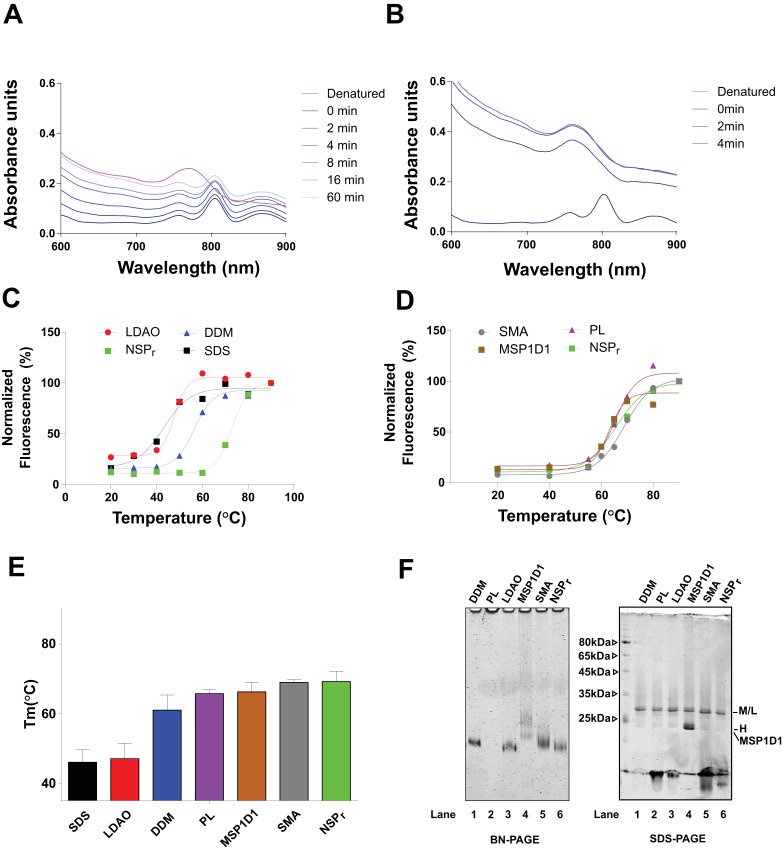
Effect of peptidisc on BRC stability.(A) Absorbance scans of the BRC complex (1 µM) in peptidisc after incubation at 65°C for up to 1 hr (blue traces). Incubation at 90°C leads to full release of the bacteriochlorophyll pigment (magenta trace). (B) Absorbance scans of the BRC (1 µM) after incubation at 65°C in 0.03% LDAO for up to 4 min. (C) Fluorescence of the BRC in peptidisc (green trace), 0.1% LDAO (red trace), 0.02% DDM (blue trace), and 0.1% SDS (black trace). The BRC (1 µM) was incubated for 5 min at the indicated temperature before fluorescence was measured (700 nm; excitation at 680 nm). (D) The experiment repeated as in C), with BRC reconstituted into MSP1D1 (1:2 BRC:MSP1D1 molar ratio, brown trace), SMA (0.1%, grey trace), Proteoliposomes (1:1600:400 BRC:DOPC:DOPG), and peptidiscs (green trace). Fluorescence were normalized to 100% after denaturation for 5 min at 90 degrees. (E) Data were fitted using a Boltzmann sigmoidal function to calculate the melting temperature (Tm). (F) Analysis of reconstituted BRC fractions on BN-PAGE (left panel) and SDS-PAGE (right panel).